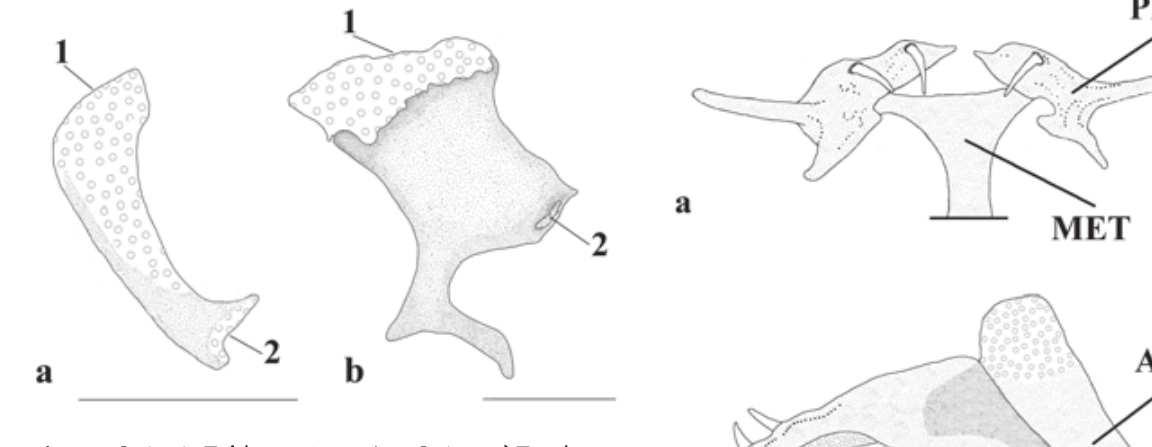
Fig. 2. Palatine in Trichomycterus , dorsal view . a ) T. anhanga , left side, INPA 36117, paratype; b ) T. hasemani , inverted of right side, MPEG 4968. Scale bars = 0.1 mm. 1 = anterior articular facets; 2 = posterior articular facets.